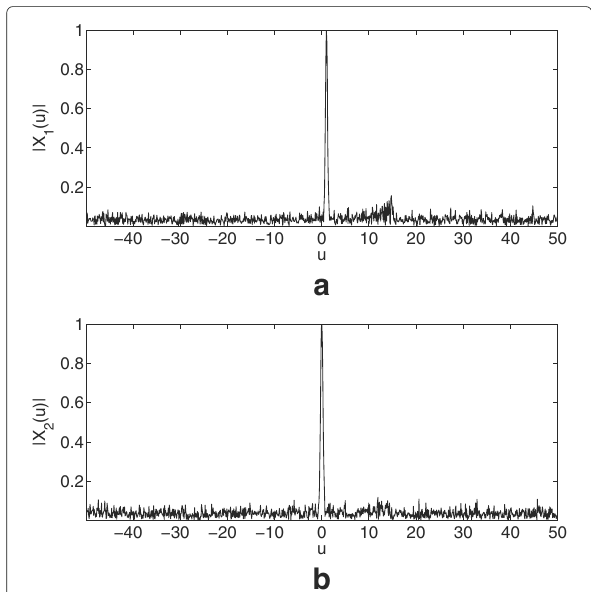
Fig. 11 Comparing the LCTs of x ( t ) under different parameters. a The LCT of x ( t ) with parameter M = ( − 6 π ,1,0, − 1 / 6 π) at SNR = 5 dB. b The LCT of x ( t ) with parameter M = ( − 6.4 π ,1,0, − 1 / 6.4 π) at SNR = 5 dB